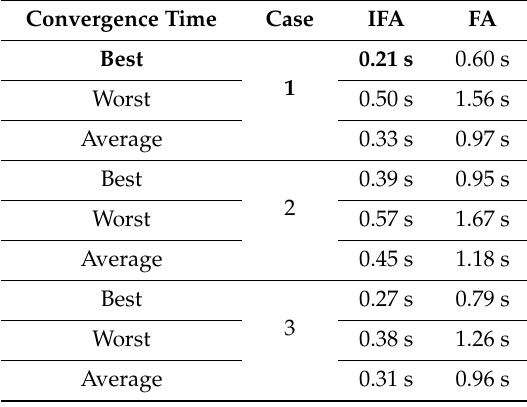
Table 3. Convergence time of FA and